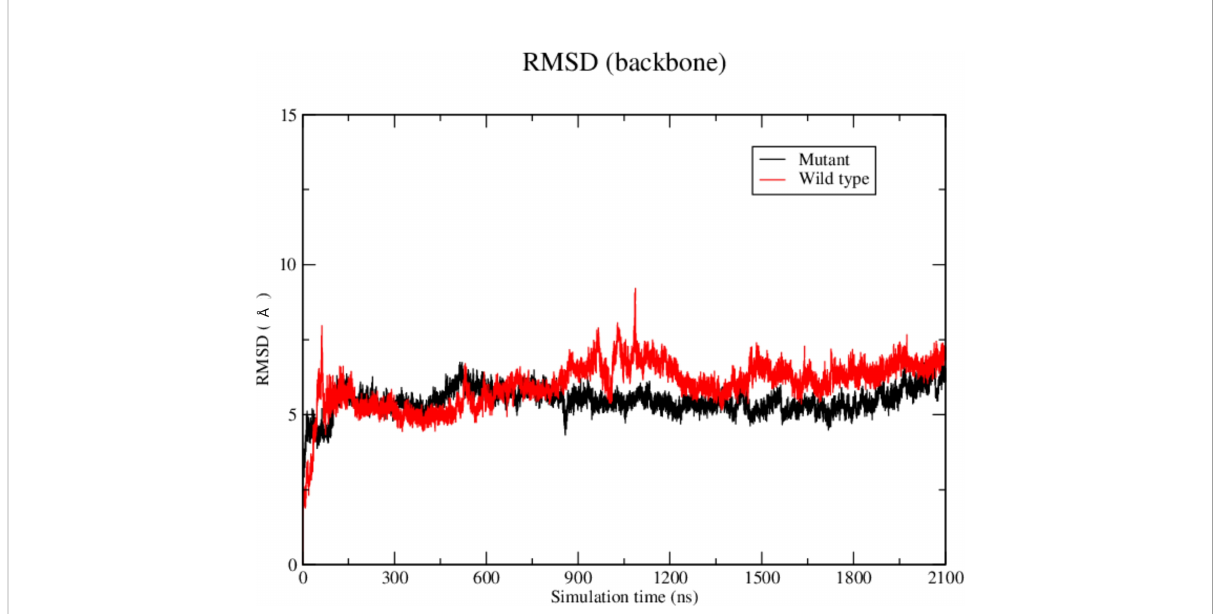
FIGURE 4 Root-mean square-deviation (RMSD) plot as a result of the molecular dynamics analysis of the wild-type (red) or mutant W228 (black) AIRE SAND domain with the SIRT1 protein. The RMSD plot shows that both WT and mutant SAND domains present a similar behavior along the fi rst 600 ns. Then, the WT SAND domain exhibited a slight offset from 600 to 900 ns, and both complexes tended to stability at approximately 1200